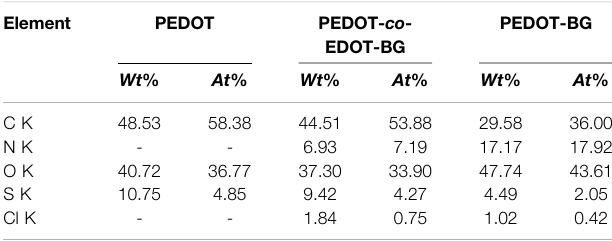
TABLE 1 | Atomic elements of PEDOT, poly(EDOT- co -EDOT-BG), and poly(EDOT-BG) polymer fi lms electrodeposited on ITO-glass slides. Element